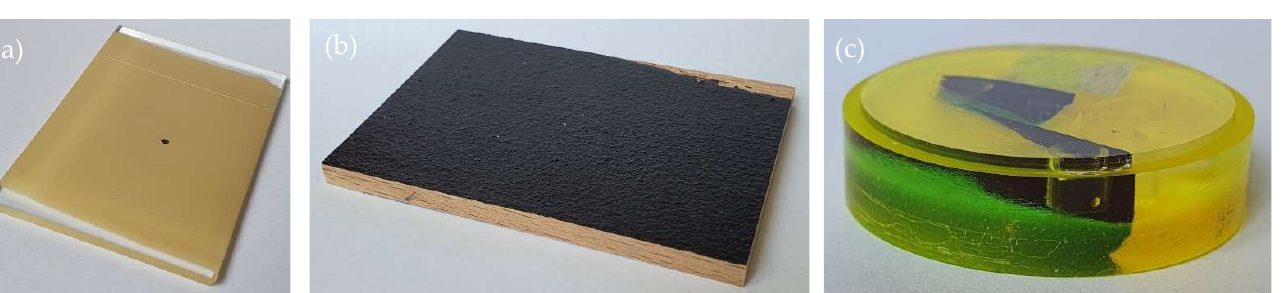
Figure 2. Prepared samples for the computer tomography.